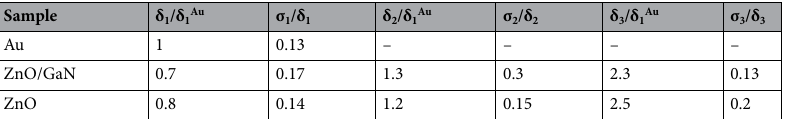
Table 1. Data on the SEY yield denoted with δ for the samples discussed in this paper. σ is indicative of the standard deviation determined from the fits shown in Fig. 4.